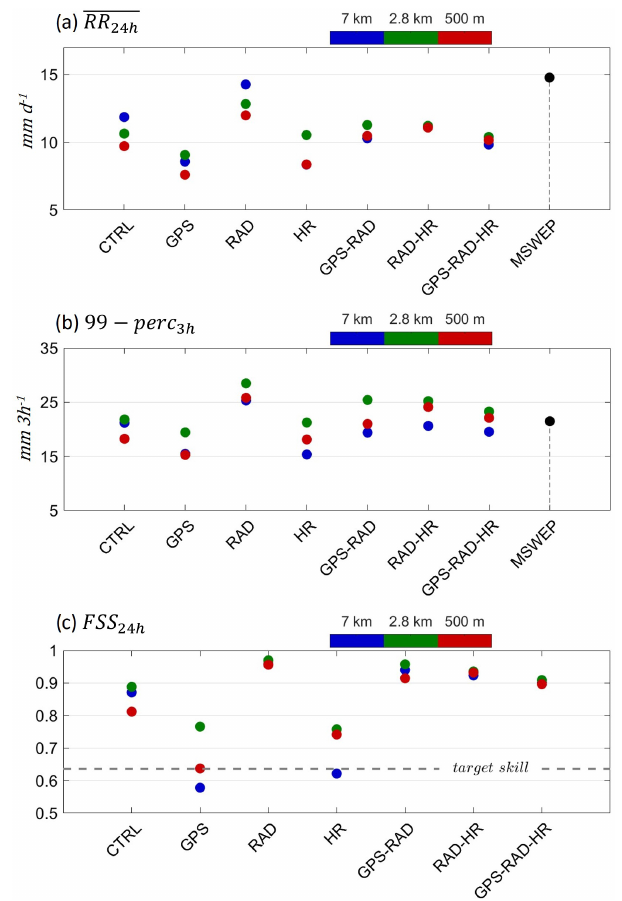
Figure 5. (a) Accumulated precipitation amount during 24 Septem- ber 2012, spatially averaged over RhoAlps, for COSMO and MSWEP. (b) The 99th percentile in millimetres per 3h over the investigation area RhoAlps during 24 September 2012. (c) FSS of 24h precipitation